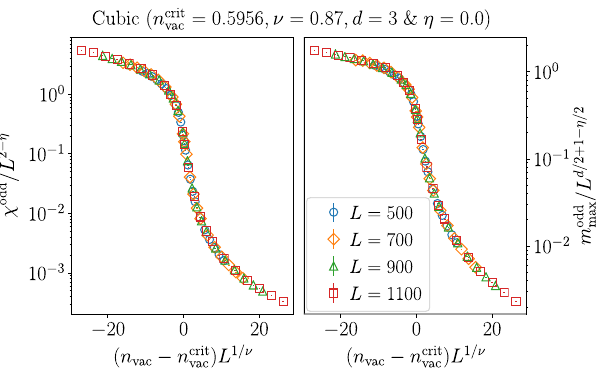
FIG. 21. Left panel: For appropriate choices of ν and η , the susceptibilities χ odd associated with the odd analog C odd ð r − r 0 Þ of the sample-averaged geometric correlation function con- structed from just odd R -type regions of three-dimensional L × L × L samples, when rescaled by L 2 − η , collapse onto a single − n crit Þ L 1 = ν for n curve when plotted as a function of ð n vac vac vac close to n crit . Right panel: The masses m odd of the largest, odd R - vac max type regions in three-dimensional L × L × L samples, when rescaled by L d= 2 þ 1 − η = 2 with d ¼ 3 , show analogous scaling behavior. This may be compared with results discussed in Sec. VII.